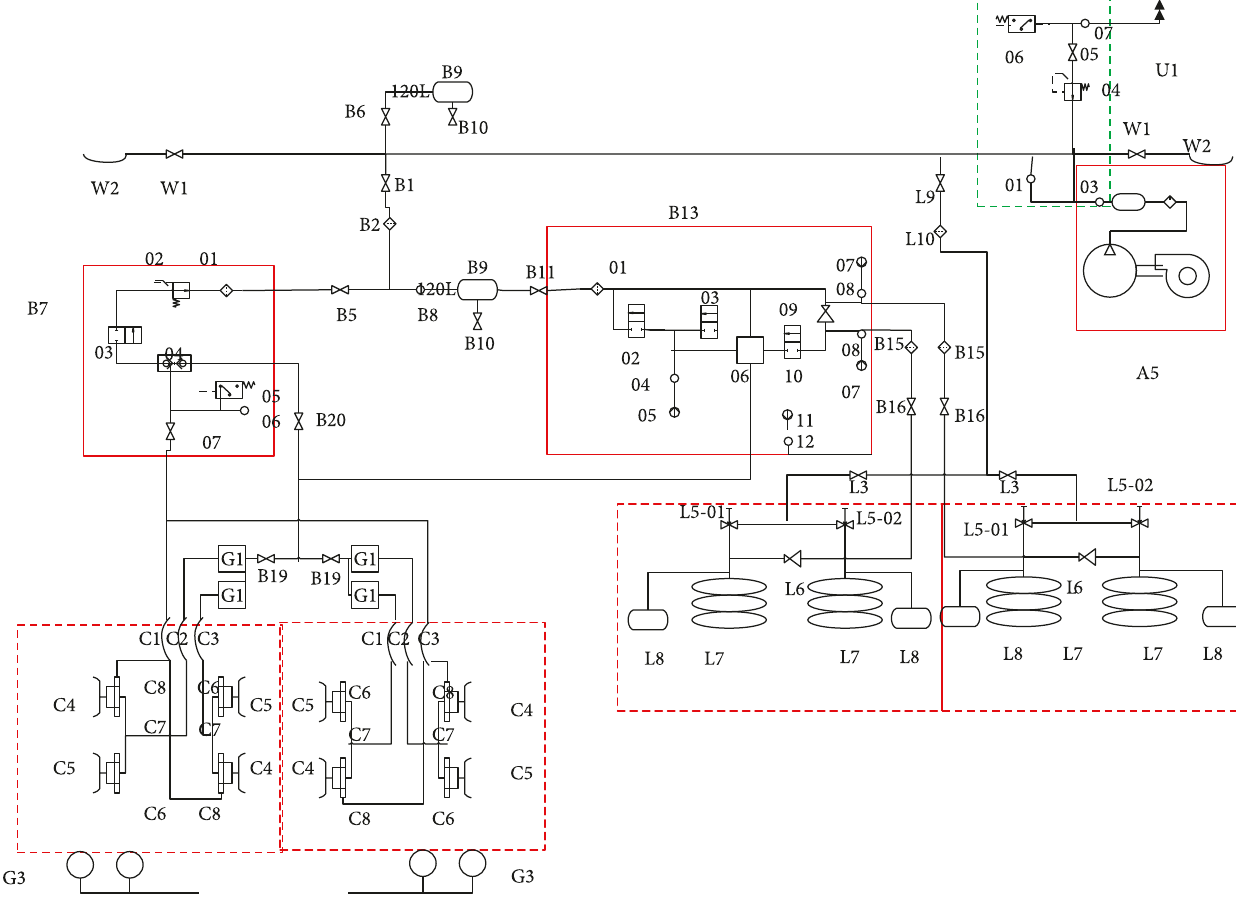
Figure 3: Schematic diagram of an urban rail transit vehicle air braking system. Table 1: Guangzhou rail transit fault